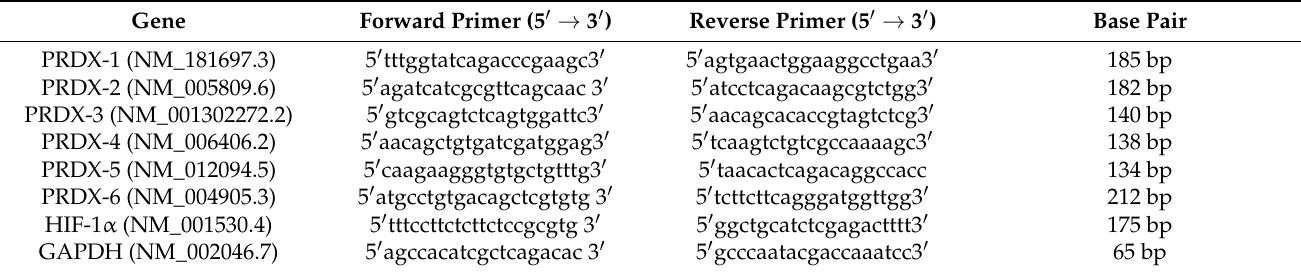
Table 2. Sequences of the forward and reverse primers used for RT-PCR